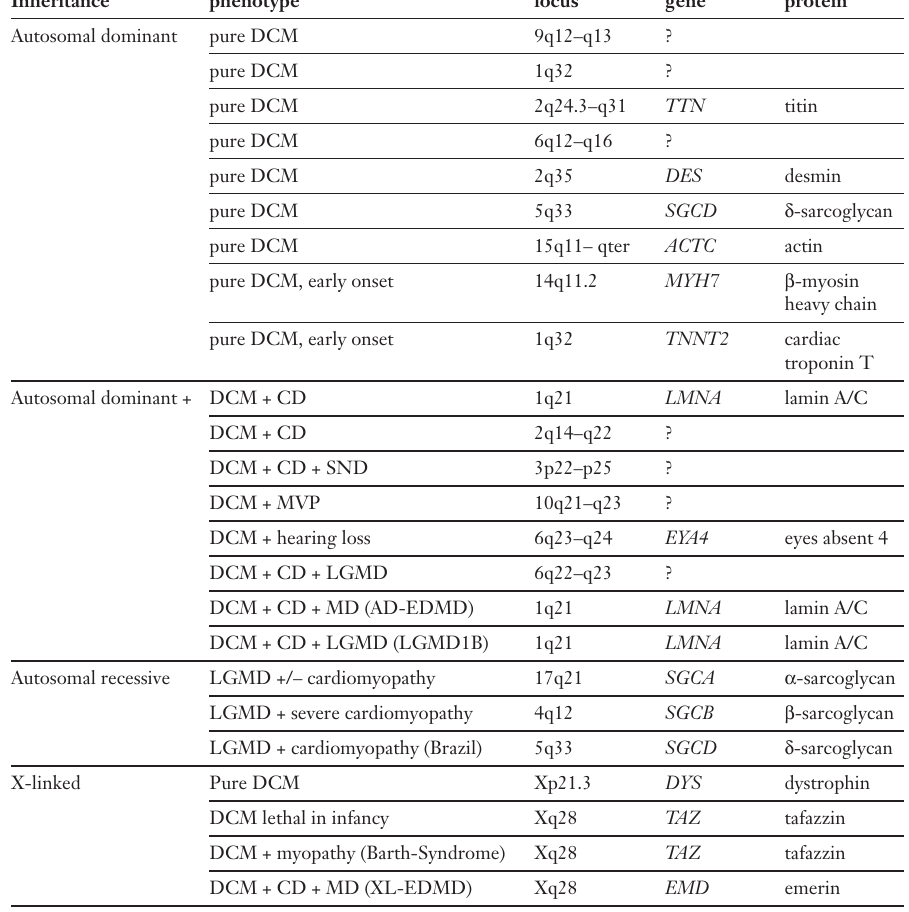
Familial dilated cardiomoypathy phenotypes, genes and